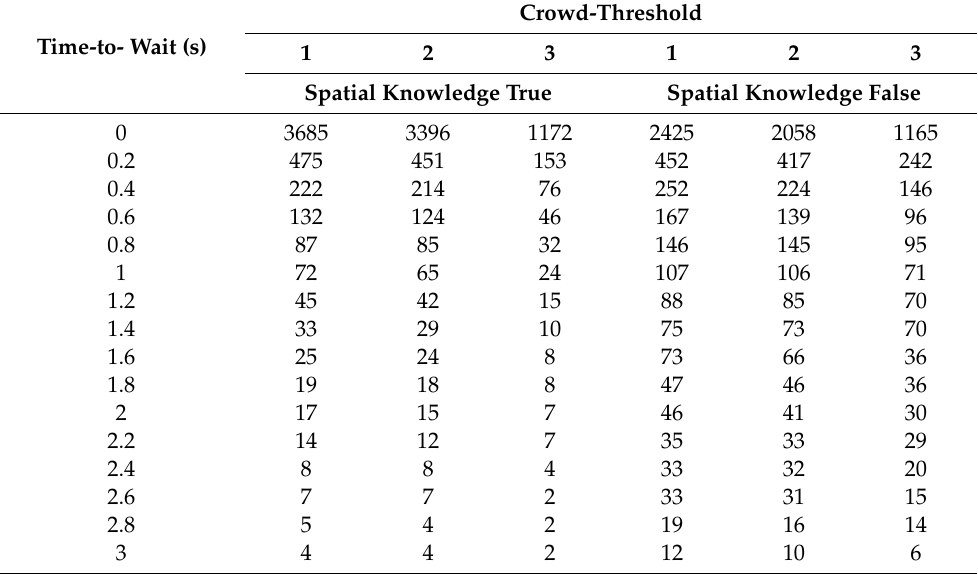
Table 3. Relation between number of reconsideration procedures triggered during evacuation and time-to-wait parameter for worst-case